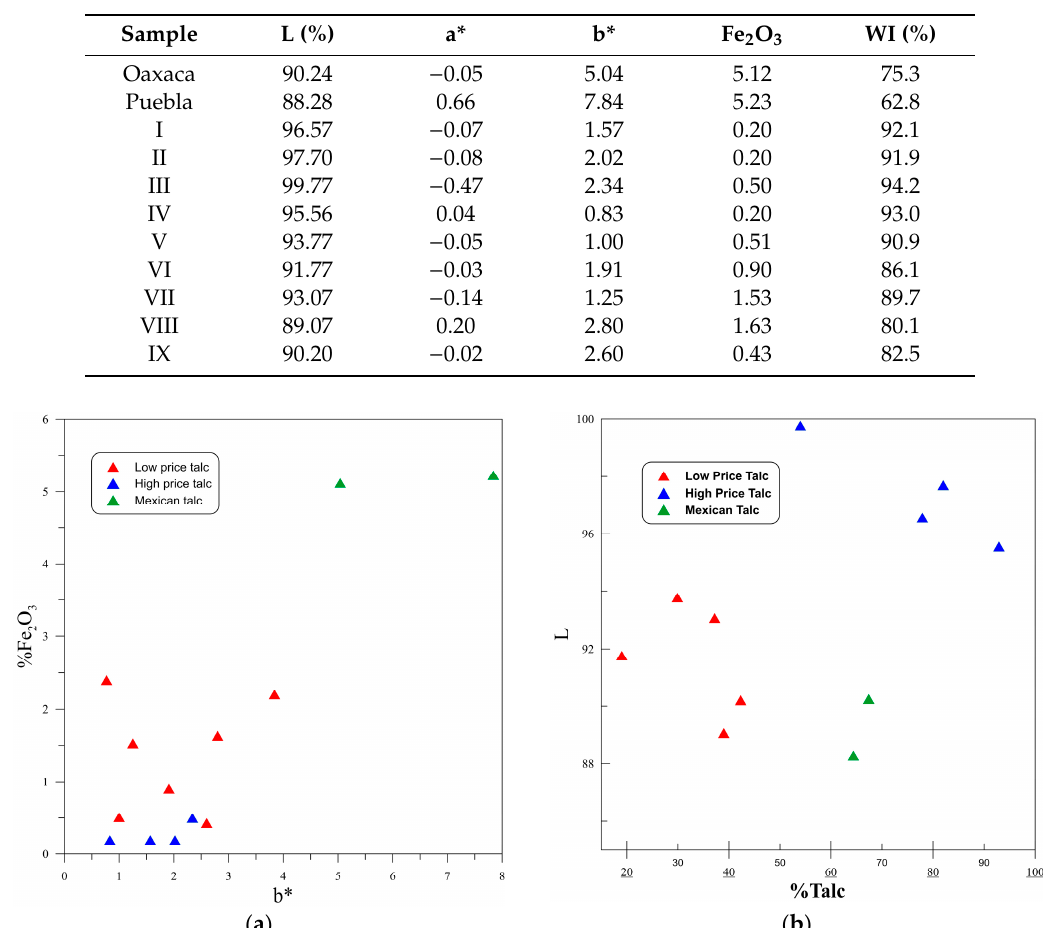
Table 1. Colorimetric values of talcs and their relationship with iron content.